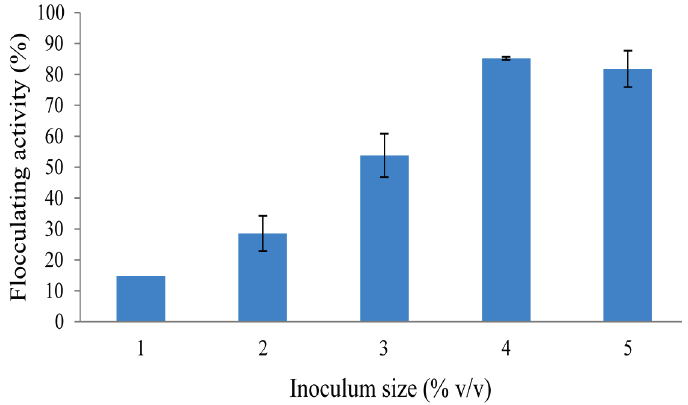
Figure 4. Effect of inoculum size on REG-6 production by Bacillus toyonensis strain